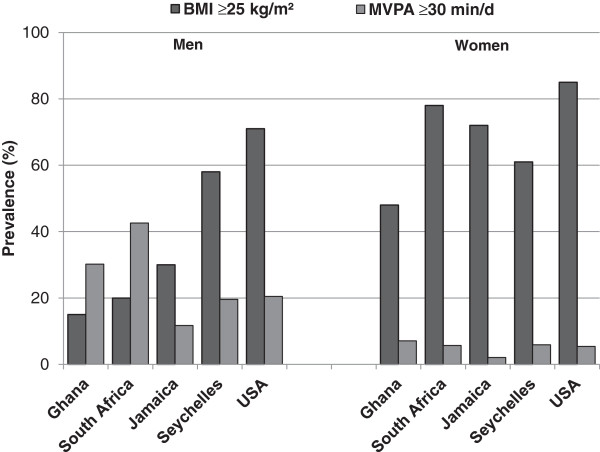
Cumulative prevalence of overweight plus obesity (BMI ≥ 25) and proportion of participants meeting physical activity recommendations (moderate-to-vigorous activity in bouts of at least 10 minutes ≥30 min/d) by site and gender.